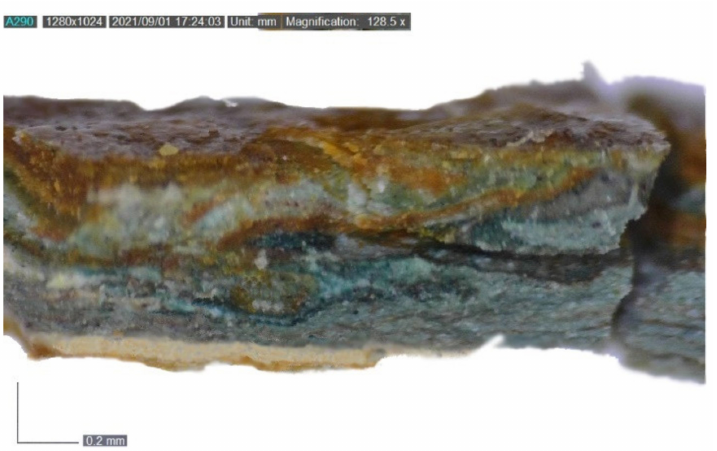
Figure 8. DinoLite image (128.5 × ) of a section of sample 1 before FT-IR ATR analysis. From the bottom to the top: canvas (partially visible), ground and primer layers, bluish-green paint layers, and varnish.